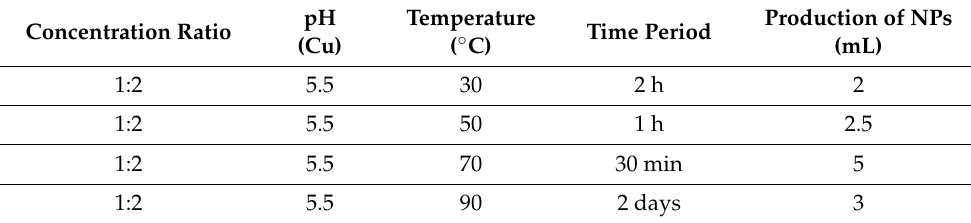
Table 3. Production of CuNPs at constant pH and concentration ratio with variable temperature.